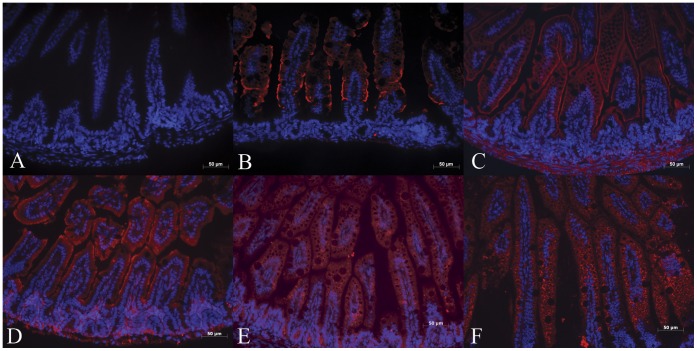
Immunohistochemical analysis of expression of fatty acid oxidation enzymes in 1-week-old wild type (OCTN2+/+) mouse ileum.Panel A is a negative control image where there was no primary antibody and panels B–F show immunoreactivity for MCAD, LCAD, VLCAD, SCHAD, and LKAT, respectively. All five enzymes are expressed mainly in the villous epithelial cells and minimal expression in non-epithelial cells of the villous core and crypts. (Bar represents 50 µm).